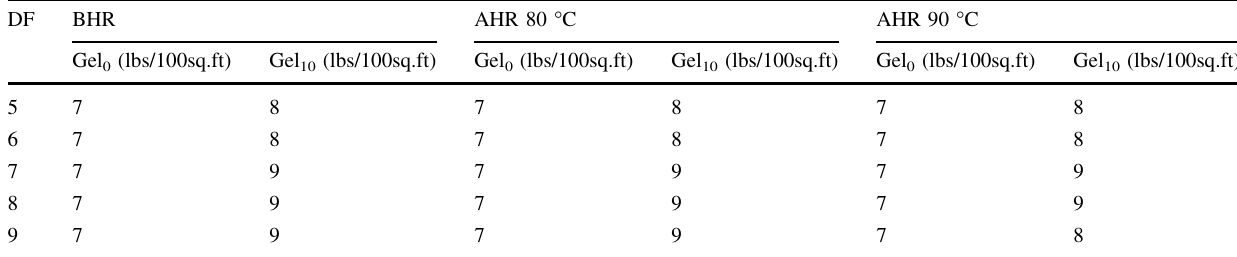
Table 9 Mud rheology of CTAB in combination with PGS in KCl-inhibited mud system DF BHR AHR 80 (cid:3) C Gel 0